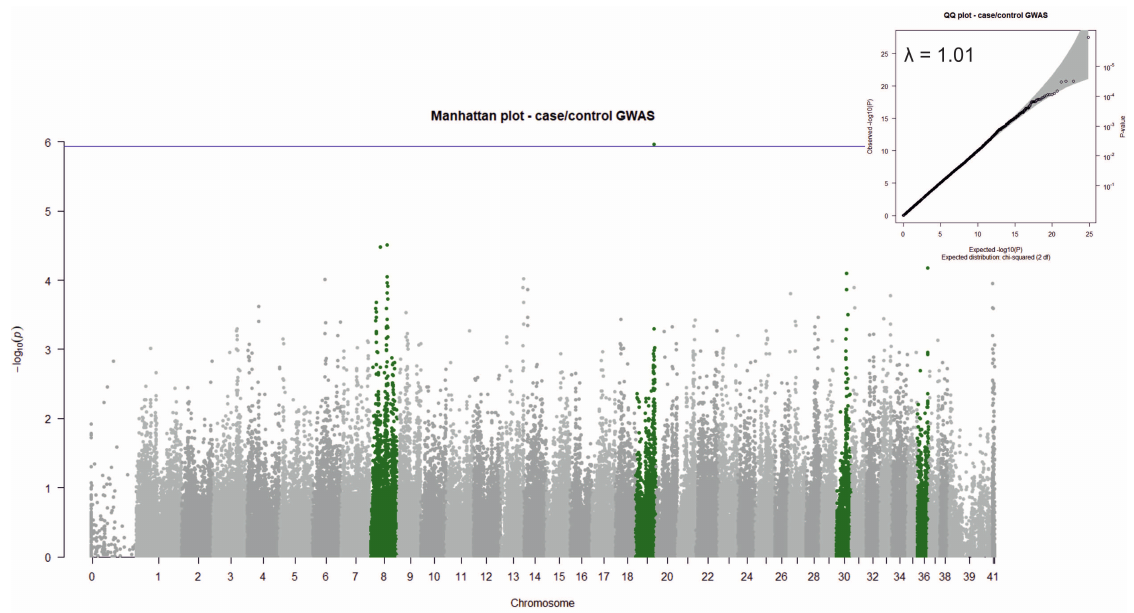
Figure 2. Manhattan and QQ plot for case/control GWAS. The chromosomes of the nine most significant SNPs are shown in green. The significance threshold (shown as a purple line) was set based on Bonferroni correction (cut-off = 1.16 × 10 − 6 ). The lambda value is shown in the QQ plot. Table 2. Genotypes of the two top SNPs from the case/control GWAS for chromosomes 19 and 8. The highest proportions in each phenotype group are underlined.